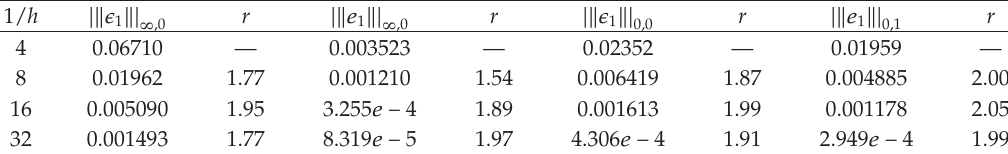
Table 3: Defect step approximation for λ (cid:9) 1000.